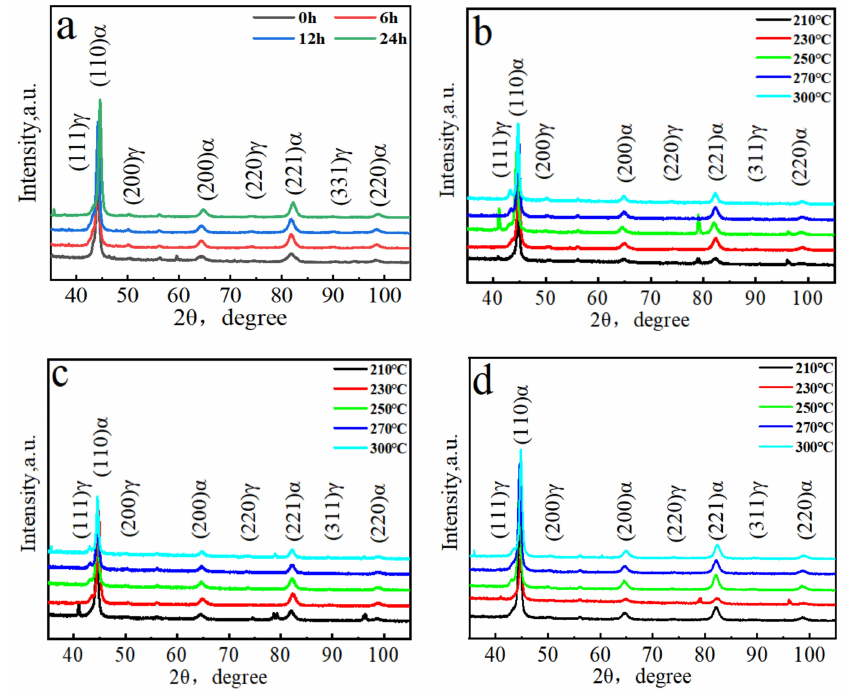
Figure 3. XRD patterns of different heat treatments processes (( a ) is at isothermal temperature of 210 ◦ C for 6/12/24 h; ( b – d ) are at different isothermal temperatures for 6/12/24